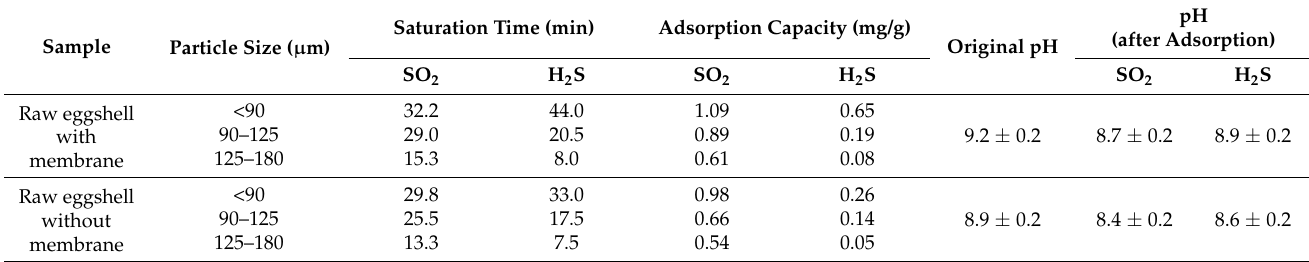
Table 4. Adsorption capacity and saturation time of raw eggshell with and without membrane at different particle size.